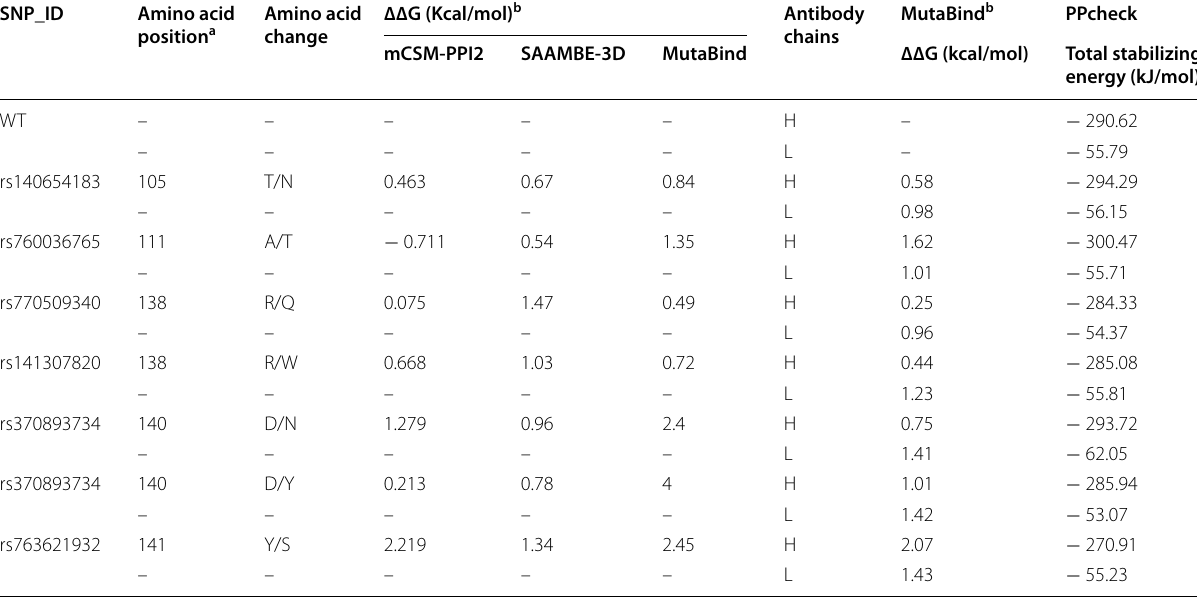
a Amino acid positions were calculated excluding the signal peptide (76 amino acids) b Positive values of ∆∆G indicate decreasing